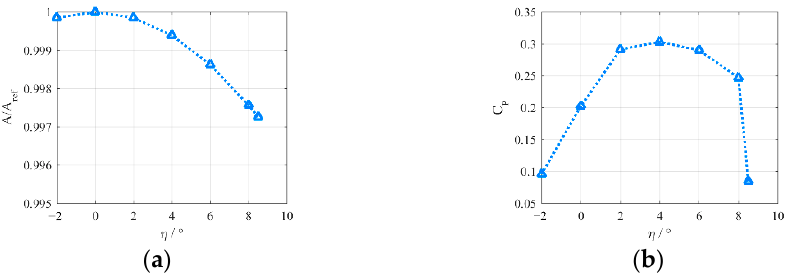
Figure 8. Variables of a wind turbine with γ = 60°: ( a ) swept area (normalized by that of the unfolded blades) and ( b ) C P .